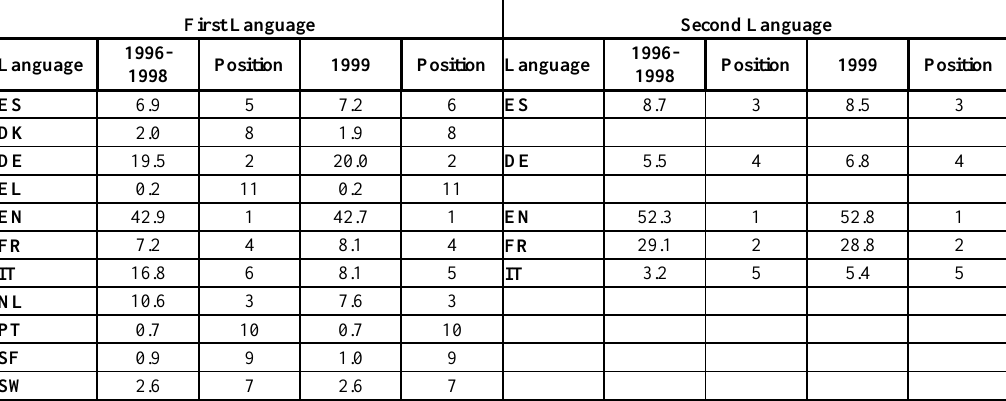
Table 2: Applications by Language (Totals, %) First Language Second